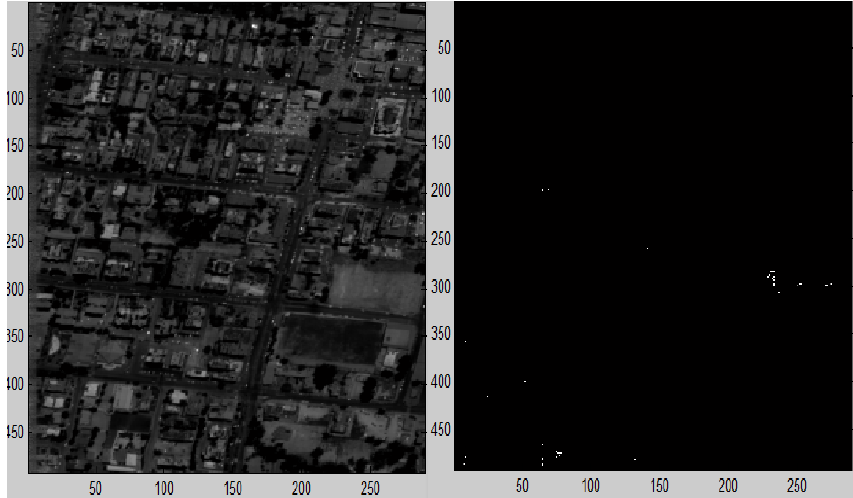
Figure 24. Left: The source image. Right: The white points contain a target with t > 0 . 5 and corr > 0 . 8